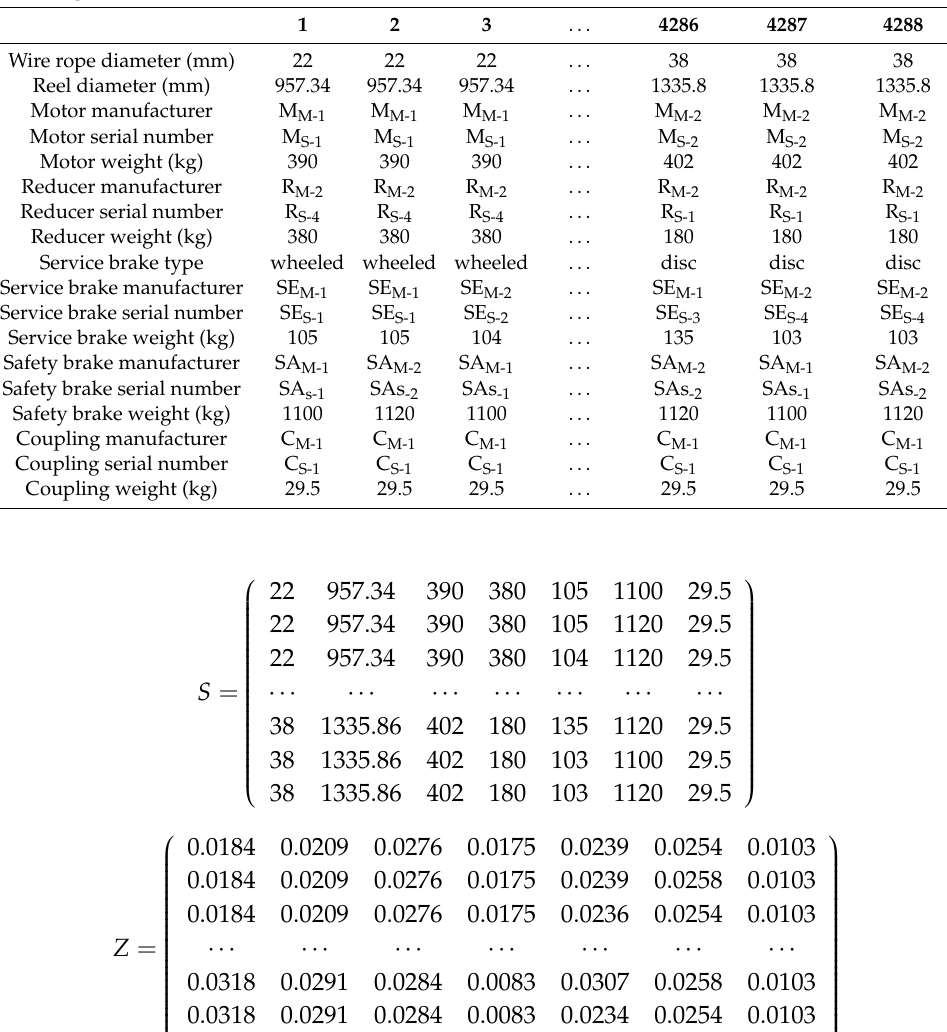
Table 7. Scheme set for instance